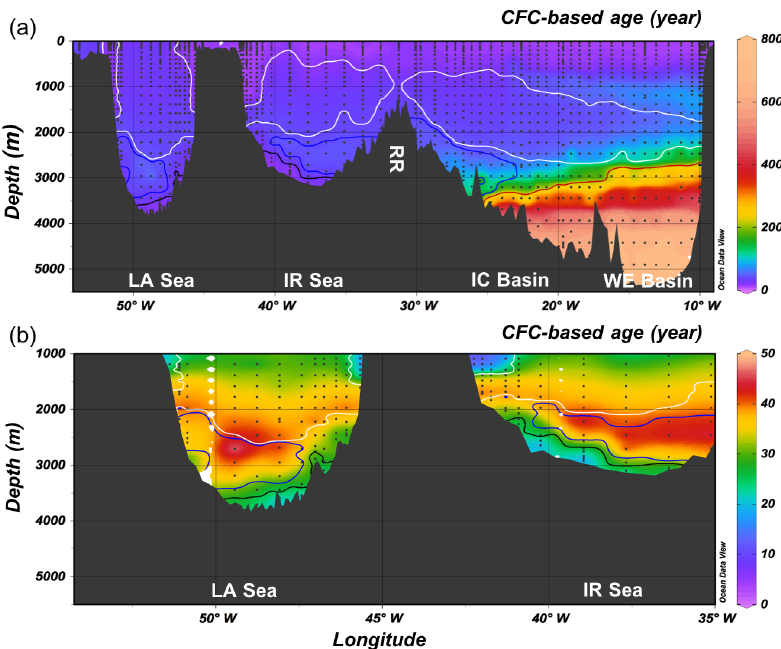
Figure 6. Water mass age based on CFC data along the GEOVIDE section. (a) full water-column data for the entire section, showing waters from 10 to 800 years in age; (b) a rescaled version of panel (a) omitting the upper 1000m and the older waters east of 35 ◦ W to show age variation in recently ventilated deep waters. Water masses were indicated by contours (black: DSOW; blue: ISOW; white: LSW; red: NEADW) based on 50% level percentage composition of source water types from eOMP